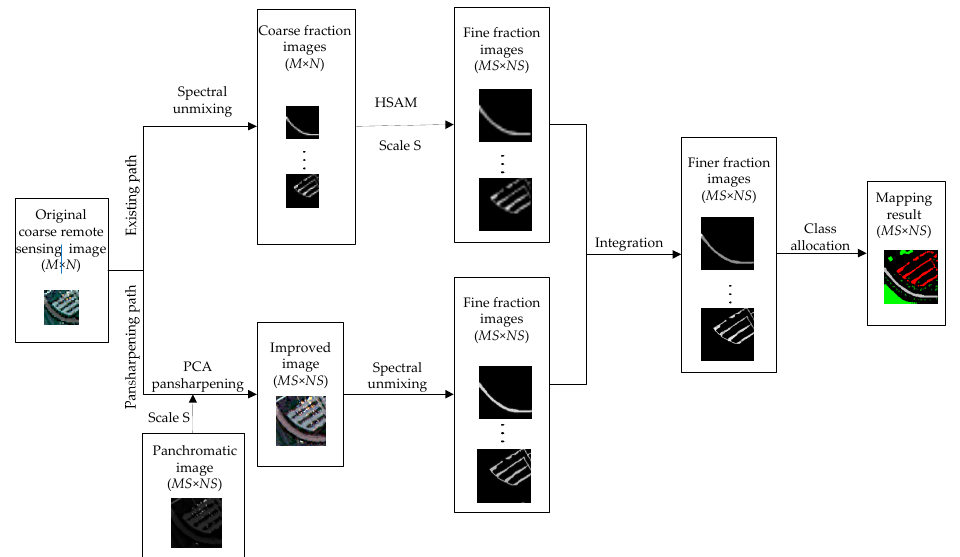
Figure 6. The flowchart of improving remote sensing image super-resolution mapping based on the spatial attraction model by utilizing the pansharpening technique (SRMSAM-PAN). spatial attraction model by utilizing the pansharpening technique